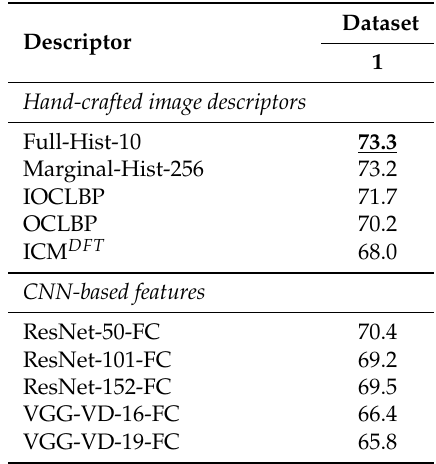
Table 14. Results of Experiment #8: non-stationary textures with variation in scale. Figures report overall accuracy by dataset. Boldface denotes the highest value; underline signals a statistically-significant difference between the best hand-crafted and the best CNN-based descriptor. Descriptors are listed in ascending order of by-experiment rank (best first).